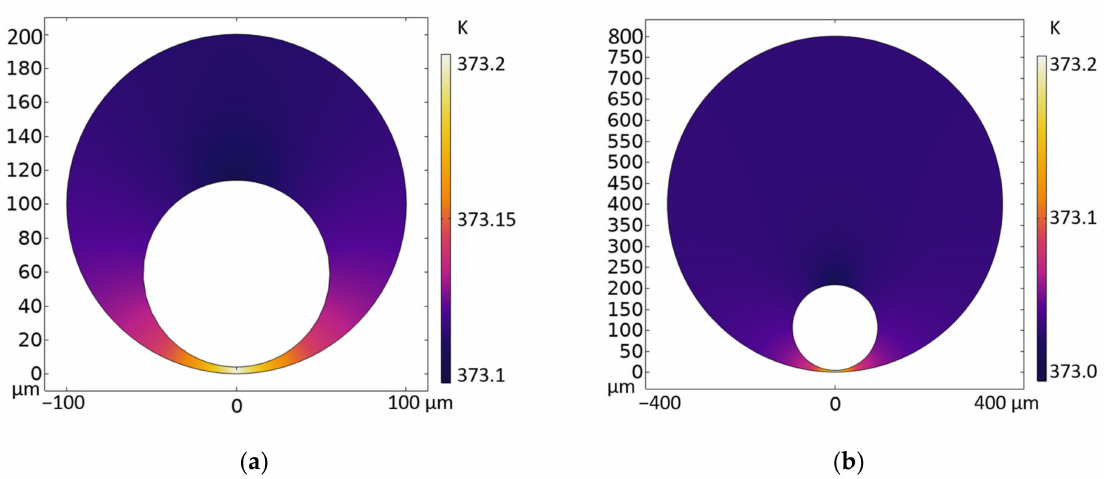
Figure 6. Simulated 2D temperature distribution maps for microbubbles generated in capillary tubes.